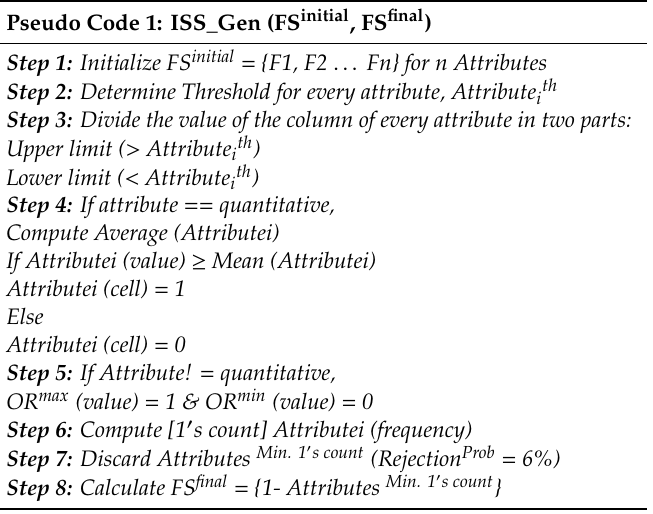
Table 4. Pseudo-code 1 for ISS_Gen (F Sinitial , F Sfinal ). [47].